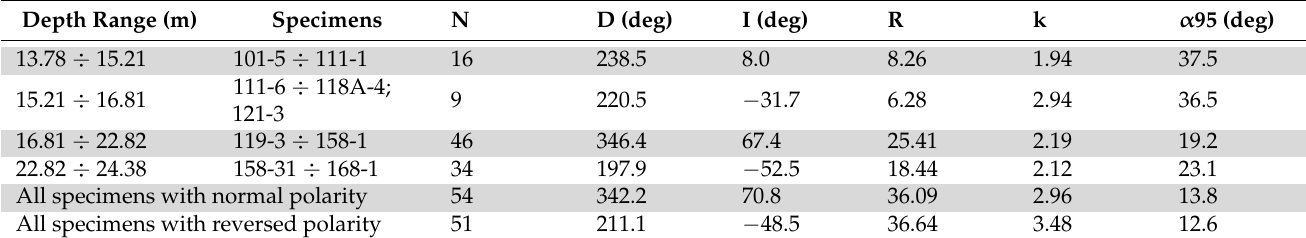
Table 4. Group statistics of palaeomagnetic data from the Dolynske-O subprofile. Depth Range